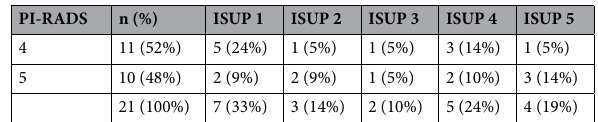
Table 2. PI-RADS Score in relation with ISUP in follow-up TB (n =